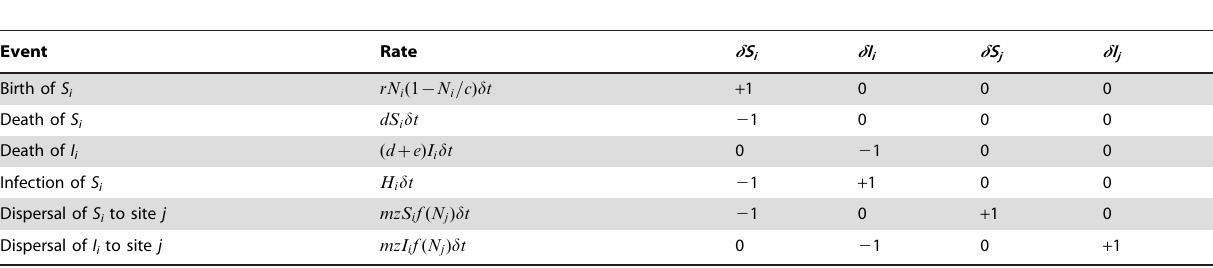
Table 1. Default event rates for the stochastic SI